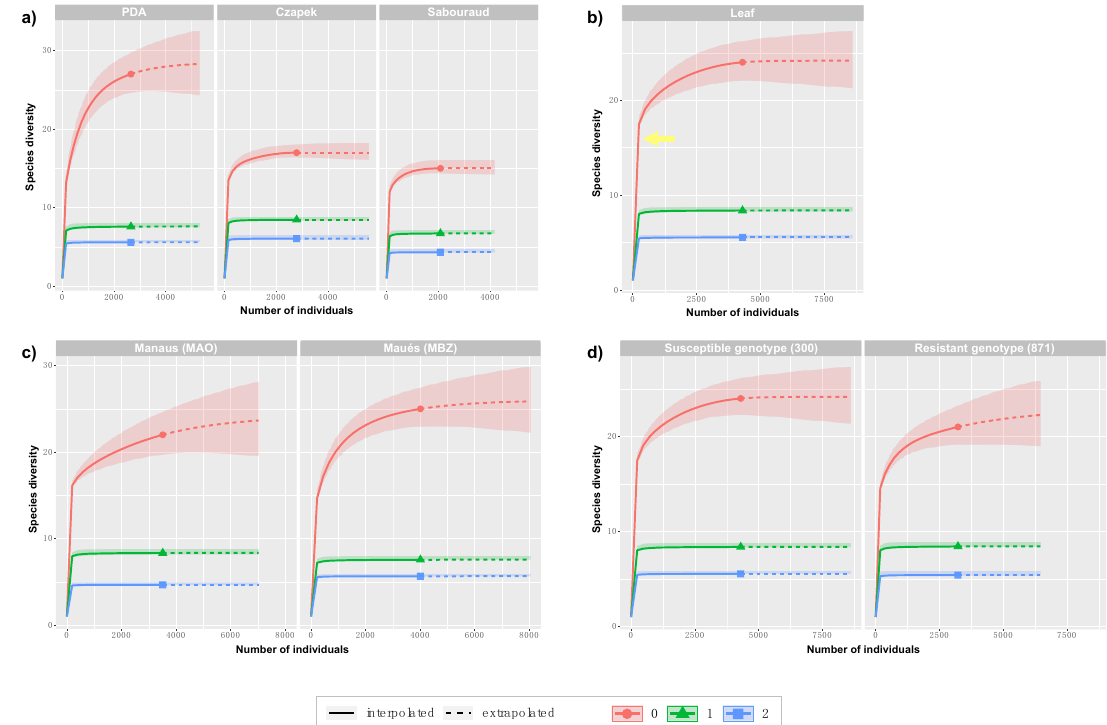
Figure 2. Rarefaction and extrapolation curves of species alpha diversity ( q = 0), Shannon diversity ( q = 1), and Simpson diversity ( q = 2) for the following comparisons: ( a ) used culture media (PDA, Czapek and Sabouraud); ( b ) plant tissue used for sampling (as no rarefaction was achieved for seeds, the yellow arrow indicates the maximum q = 0 value estimated for seeds); ( c ) municipalities of Manaus (MAO) and Maués (MBZ) where guarana samples were collected; and ( d ) susceptible (BRS300) and resistant (BRS871) guarana genotype.